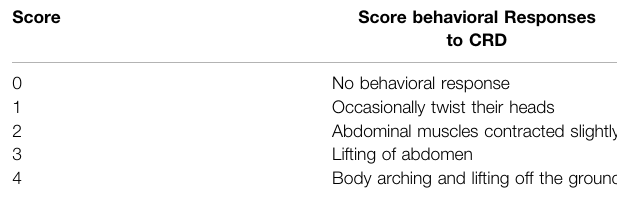
TABLE 1 | Criteria for AWR